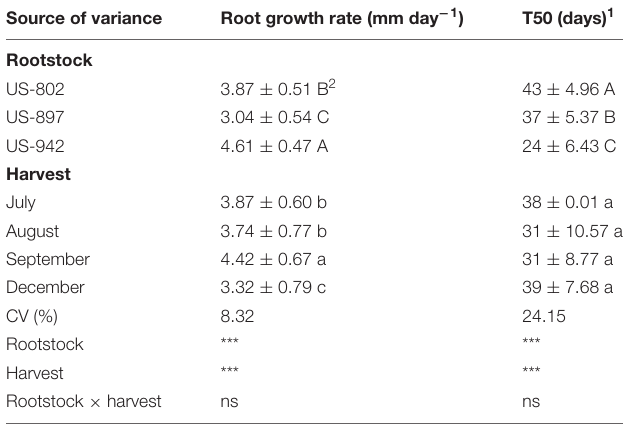
TABLE 4 | Seedling root growth rate and days to reach 50% of the total emergence of three citrus rootstocks during different period of seed extraction